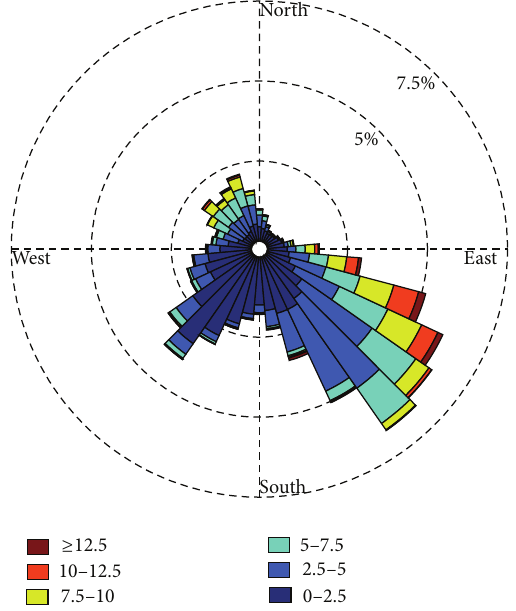
Figure 4: Wind rose for the investigation period July 2011 to June 2012, built with data of the sonic anemometer at the eddy covariance site (compare Figure 1(b)). Different wind classes are represented by different colours (see legend, values in ms −1 ); the dashed circles represent the relative